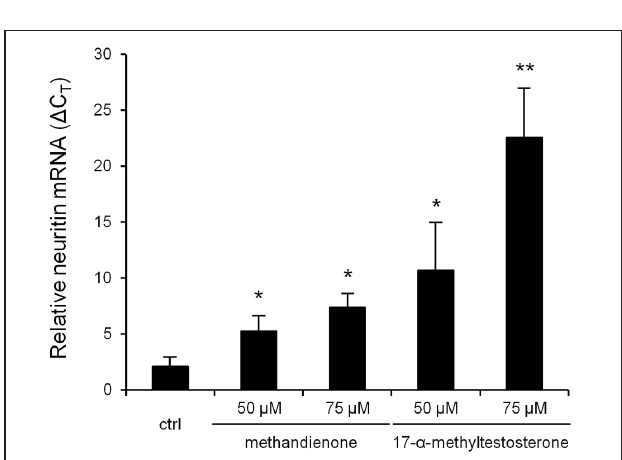
FIGURE 6 | Levels of neuritin mRNA ( (cid:2) C T , Y-axis ) in PC12 treated for 24h in the indicated concentrations of AAS, as determined by RT-qPCR normalized to GAPDH, reveal a dose-dependent increase in transcription. Experiments were repeated three times and data expressed as mean ± SD ( ∗ P ≤ 0 . 05; ∗∗ P ≤ 0 .